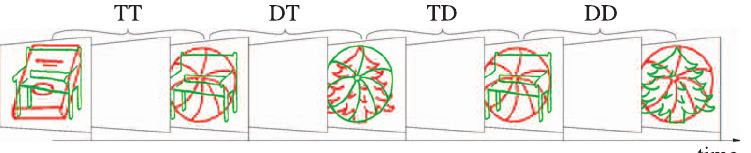
Figure 1. An example sequence of stimuli of Experiment 1 in the part with target color green. All realized experimental conditions are shown except the control condition, i.e., unrelated objects in prime and probe. The fixation cross is omitted in the shown sequence for clarity.